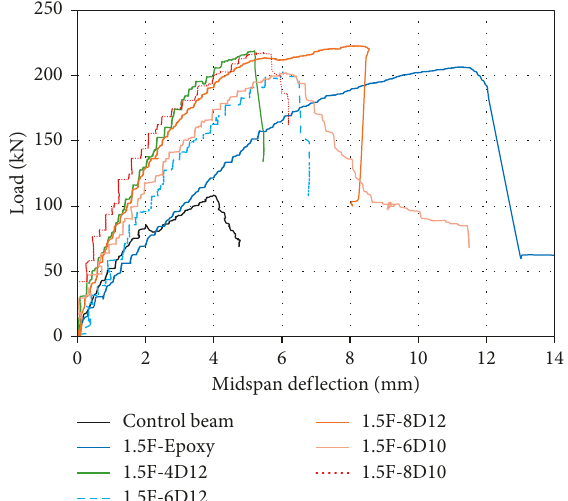
Figure 5: Load-deflection curves for beams with various con- nection details.